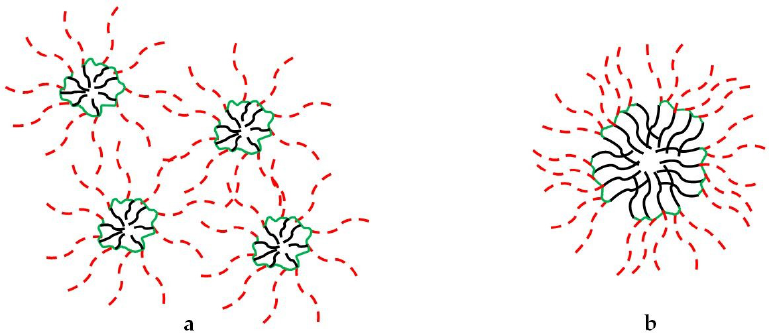
Figure 2. Unimolecular micelles can self-assemble forming ( a ) multi-micelle aggregates and/or ( b ) primary micelles.